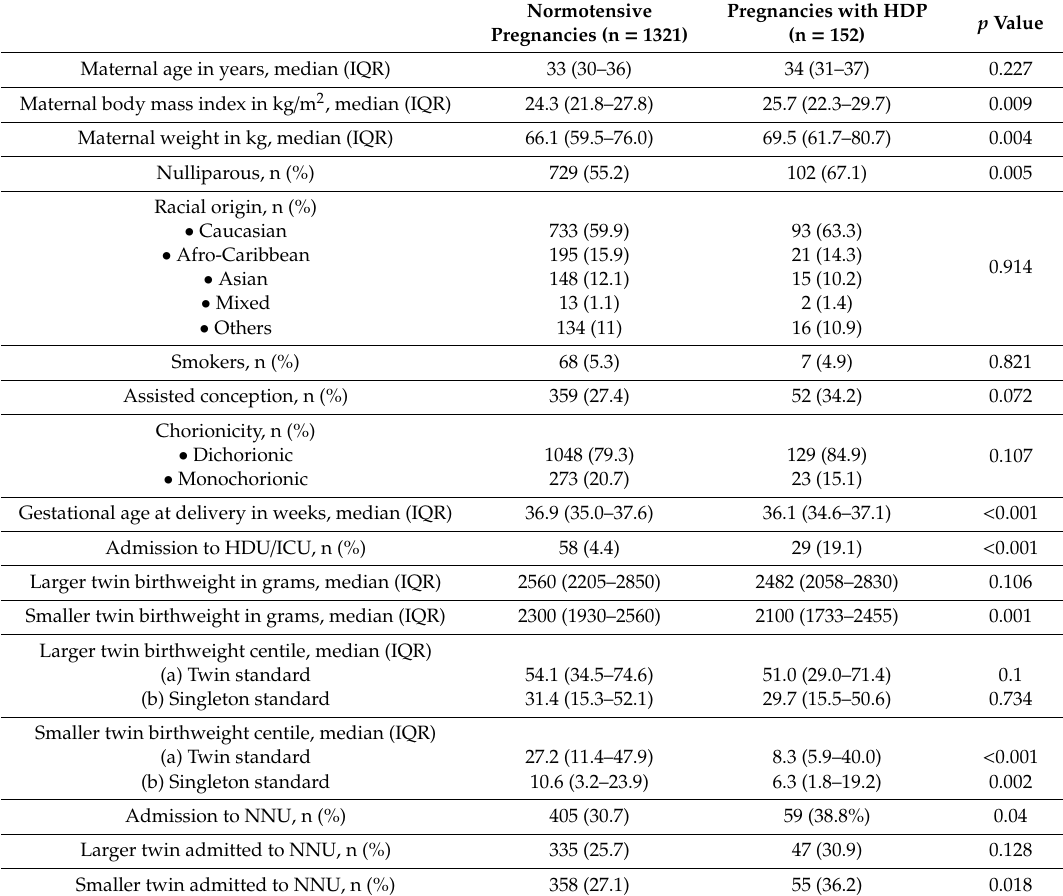
Table 1. Baseline characteristics of twin pregnancies complicated by hypertensive disorders of pregnancy (HDP) compared to normotensive twin pregnancies.